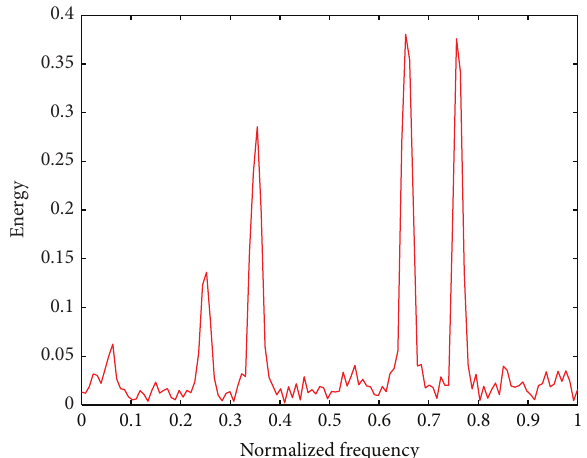
Figure 6: Energy spectrum of constant modulus constrained wave- form.